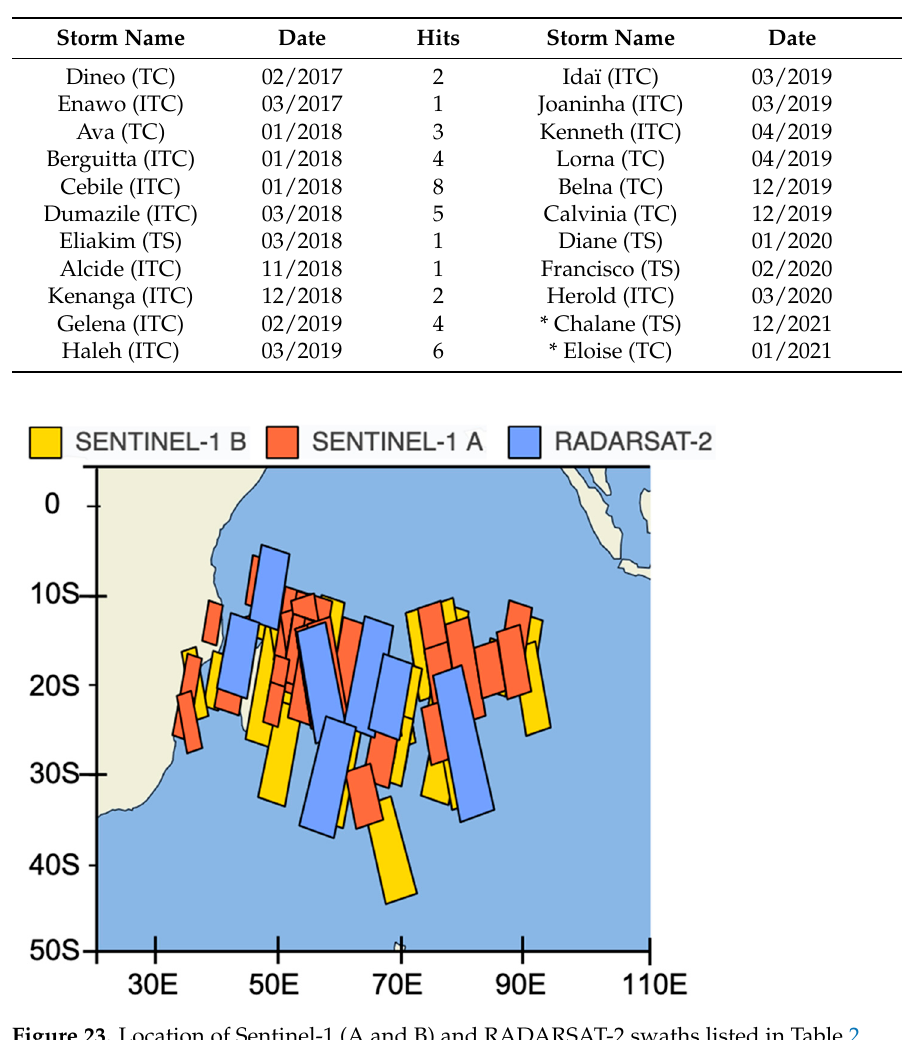
Table 2. Number of Radarsat-2 and Sentinel-1 SAR acquisitions within the eyewall/eye (hits) of tropical storms (TSs) and tropical cyclones (TCs, ITC) that developed in the SWIO between February 2017 and 2021. * Acquisitions performed from 2021 onwards were made in the frame of the CYMS program (see Section 4).